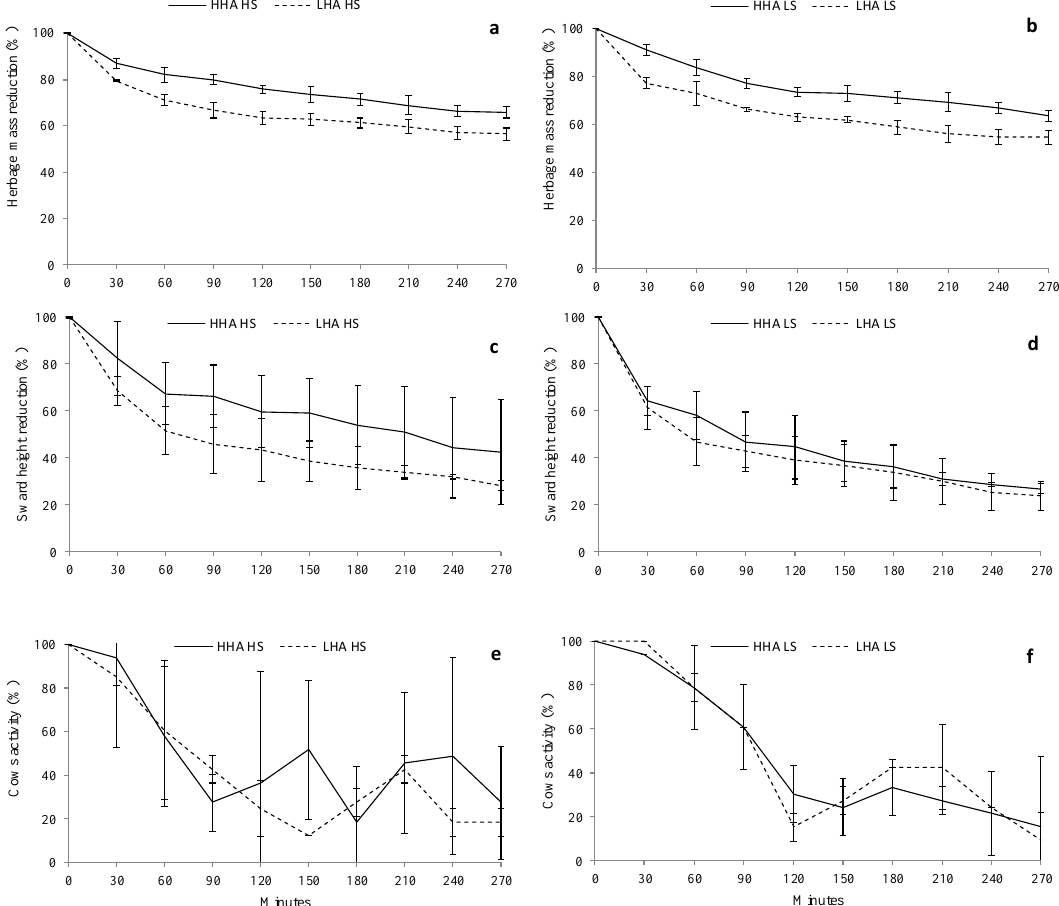
Figure 2. Herbage-mass decline (a,b), sward height decline (c,d) and proportion of cows engaged in grazing activity (e,f) during grazing sessions of 270 min. Data are means drawn from three measurement periods. Curves were fitted to high (solid line) and low (dashed line) daily herbage-allowance treatments. Figures on the left and right are high (HS) and low (LS) levels of maize silage supplementation values, respectively. Vertical bars represent s.e.m. values.